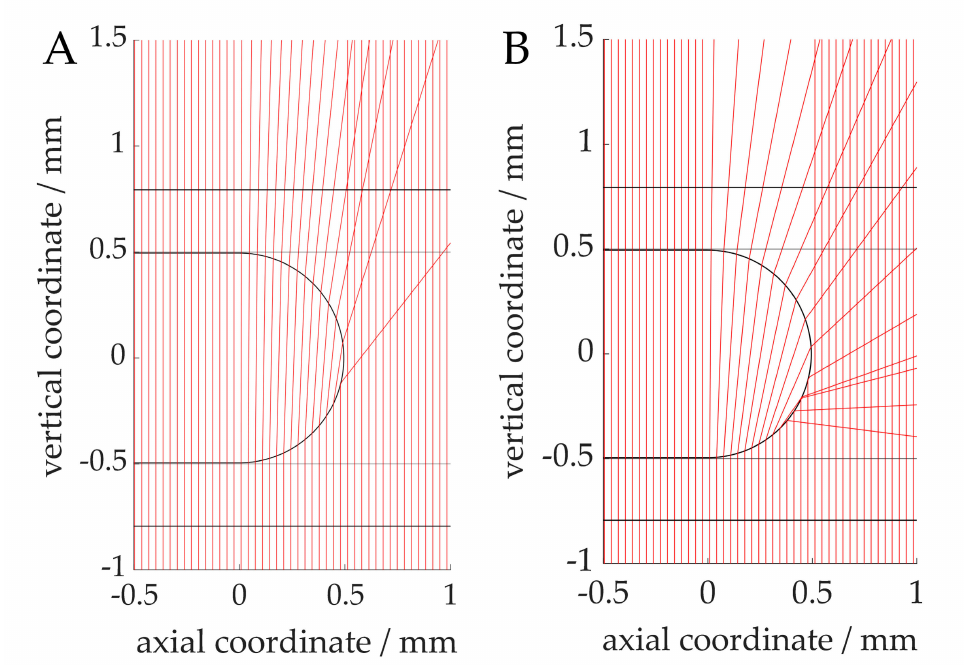
Figure 9. Simulated light refraction through capillary in horizontal cross-sectional view. External medium: air, capillary: FEP,wallfilm: 1-hexanol(notvisibleduetoitslowthickness), continuousmedium: 1-hexanol, bubbles: water ( A ), nitrogen ( B ). The phototransistor can be assumed to be located at approximatively the 1 mm radial